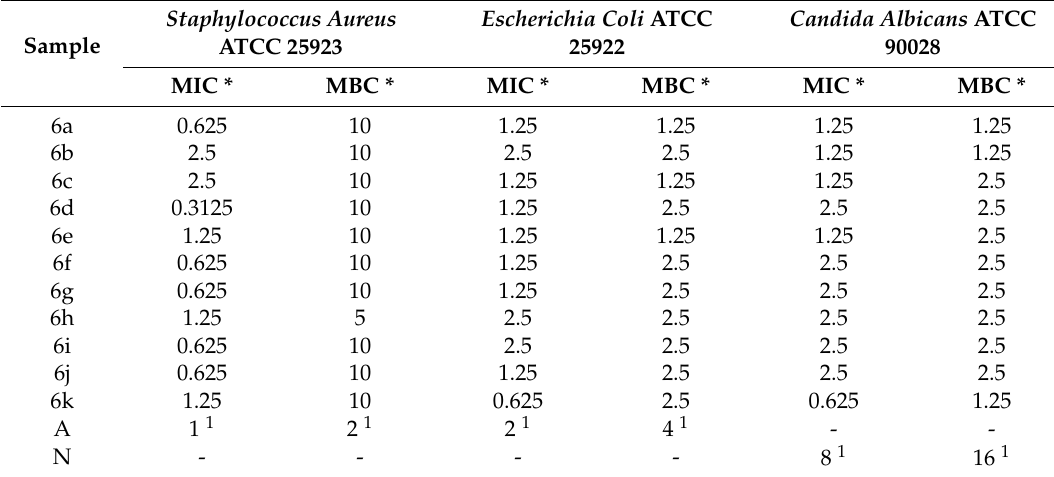
Table 4. Antimicrobial activity expressed as MIC and MBC values (mg/mL) of XTDs